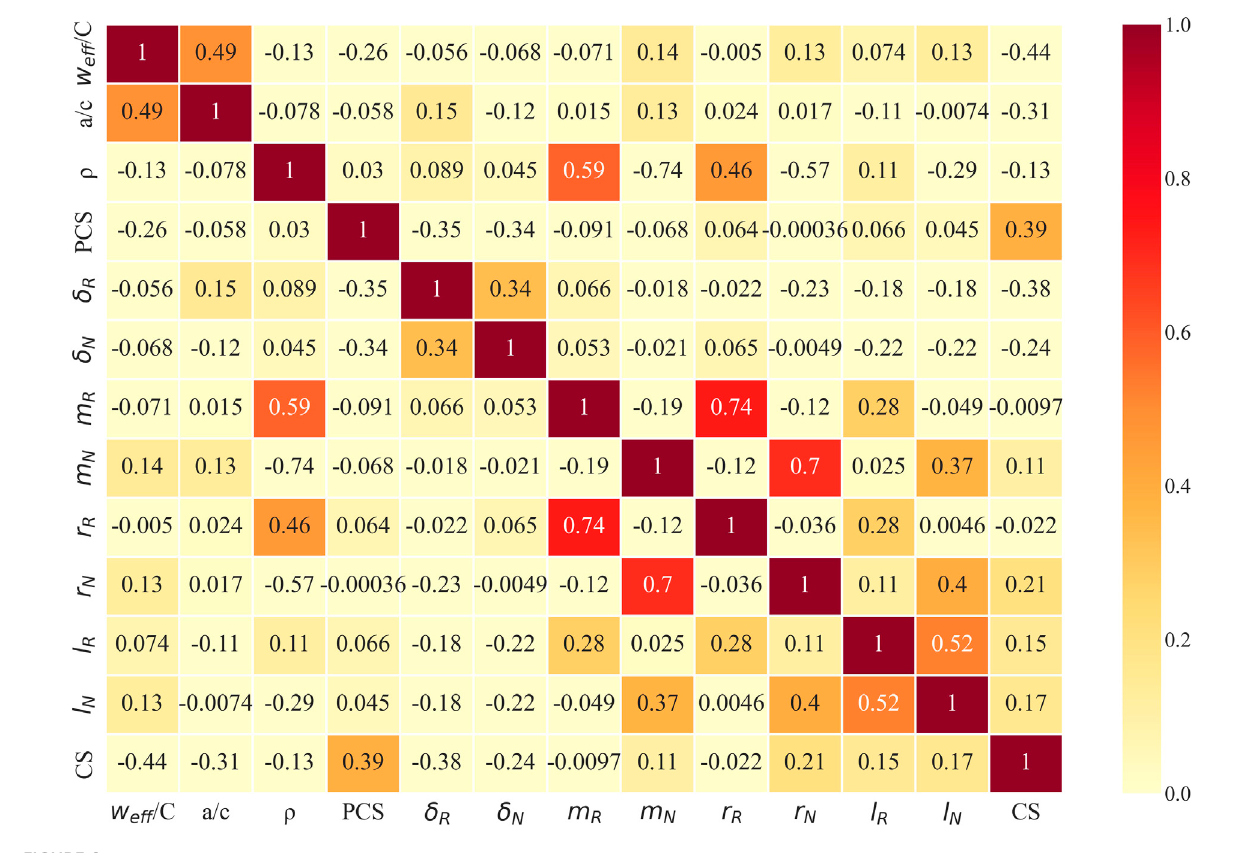
FIGURE 8 Input parameter data distribution Multi-correlation matrix of the input parameters and